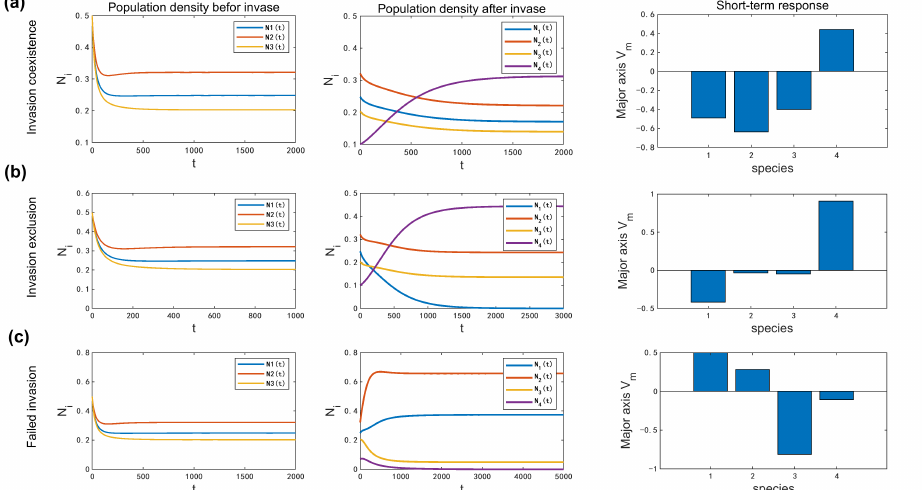
Figure 5. The long-term evolution dynamics and short-term response of all species in case 2 and θ = 0.7. There are three kinds of consequence in this scenario. We choose the parameter values from ( a ) invasion coexistence ( b ) invasion exclusion and ( c ) failed invasion. The first two columns show long-term population evolution before and after invasion. The last column suggests the major axis (i.e., the eigenvector of the lead eigenvalue) of the joint matrix, revealing how each species dynamically responds to the invasion. Other parameters are same with Figure